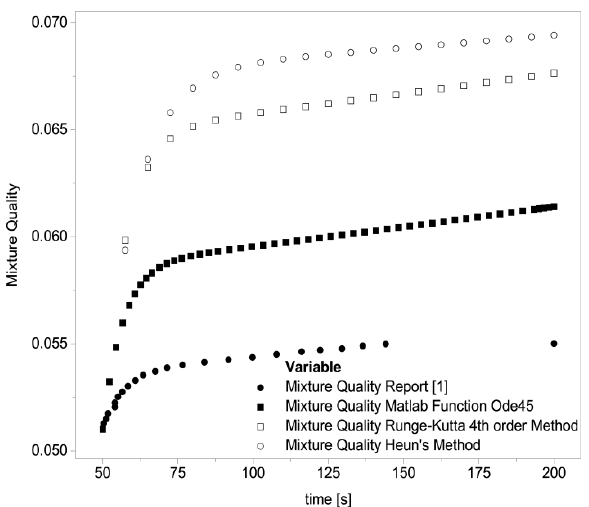
Figure 11. Behavior of the mixture quality with the different solution methods (Ode45, Runge – Kutta, Heun).